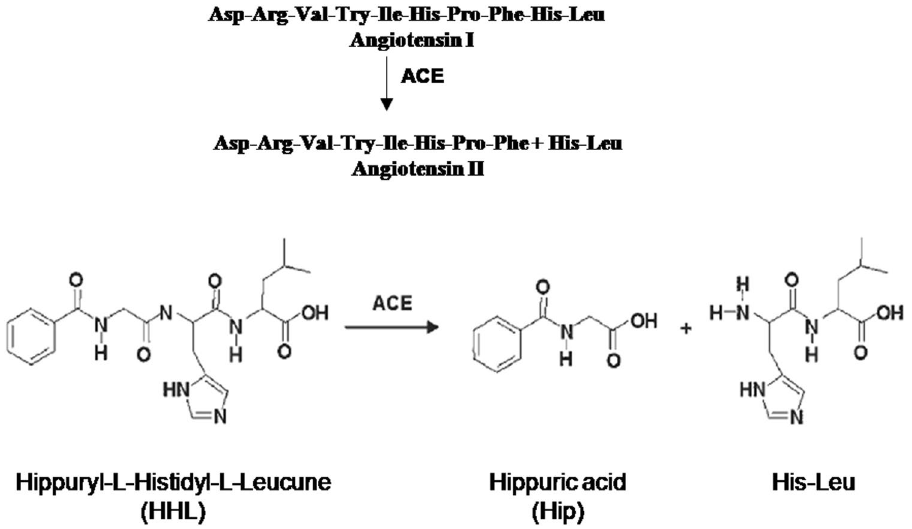
Figure 1. Reactions catalyzed by the Angiotensin-converting enzyme of